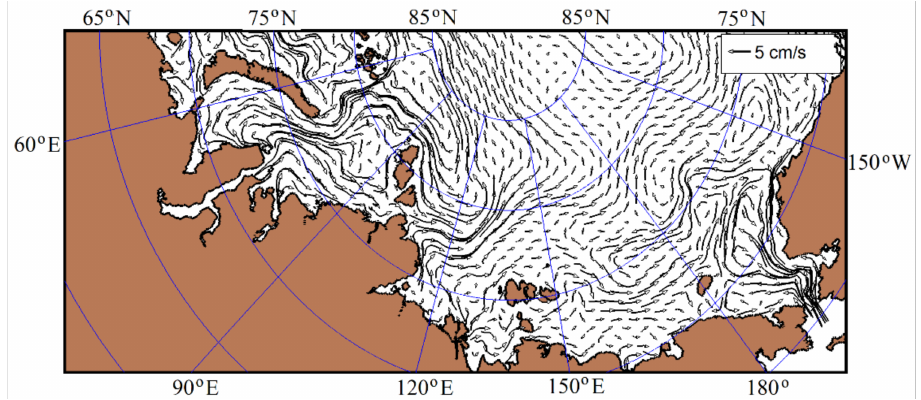
Figure 5. Circulation of the surface layer in summer 2019. Numerical simulation